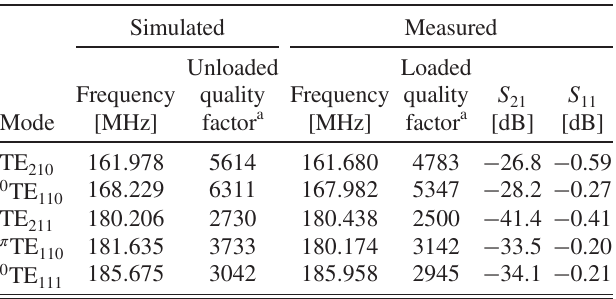
TABLE V. Comparison of the simulated and measured parameters.